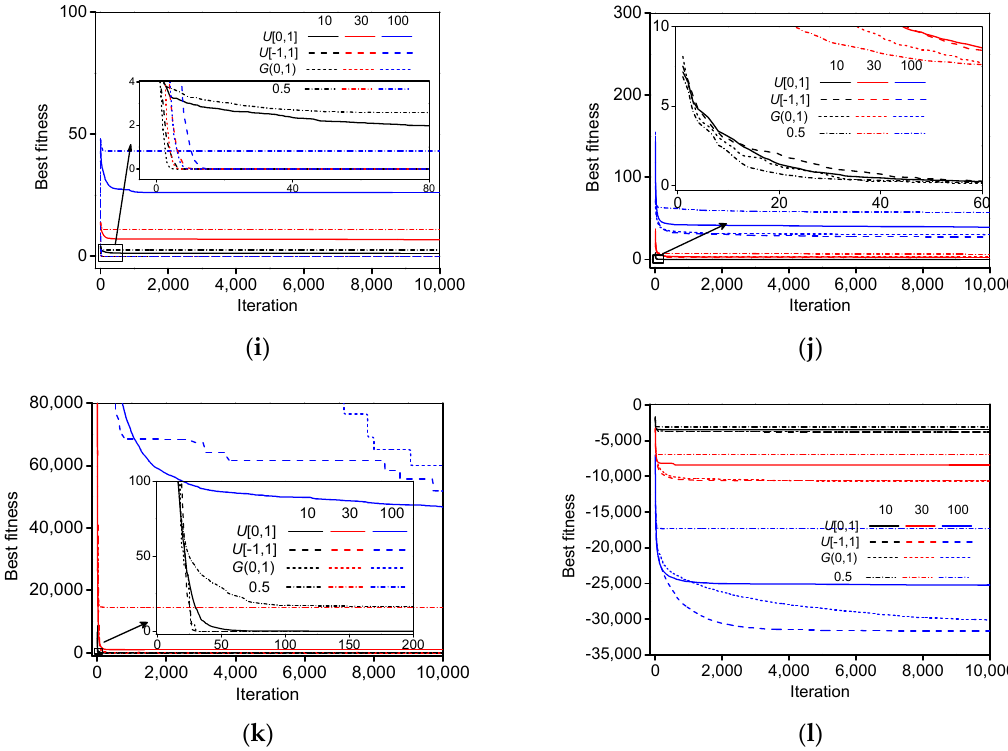
Figure 5. The mean best fitness of standard PSO algorithm with different types of random values for benchmark functions: ( a ) Sphere1; ( b ) Sphere2; ( c ) Rastrigin; ( d ) Rosenbrock; ( e ) Griewank; ( f ) Ackley; ( g ) Levy and Montalvo 2; ( h ) Sinusoidal; ( i ) Rotated Expanded Scaffer; ( j ) Alpine; ( k ) Moved axis parallel hyper-ellipsoid; ( l ) Schwefel. (The solid, dash, short dash and short dash dot lines represent the random values generated by uniform distribution in the ranges of [0, 1] and [ − 1, 1], Gauss distribution, and 0.5, respectively; the black, red and blue lines represent the space dimensions 10, 30, and 100, respectively).